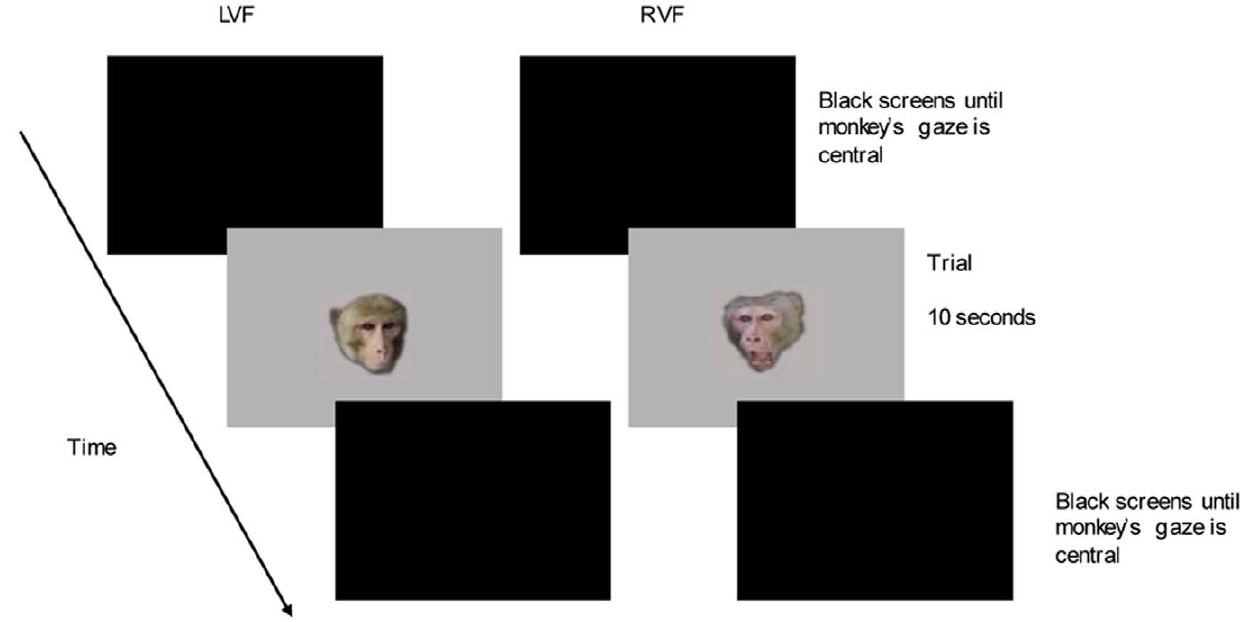
Figure 3. Example of an experimental trial showing an aggressive-neutral face pair.